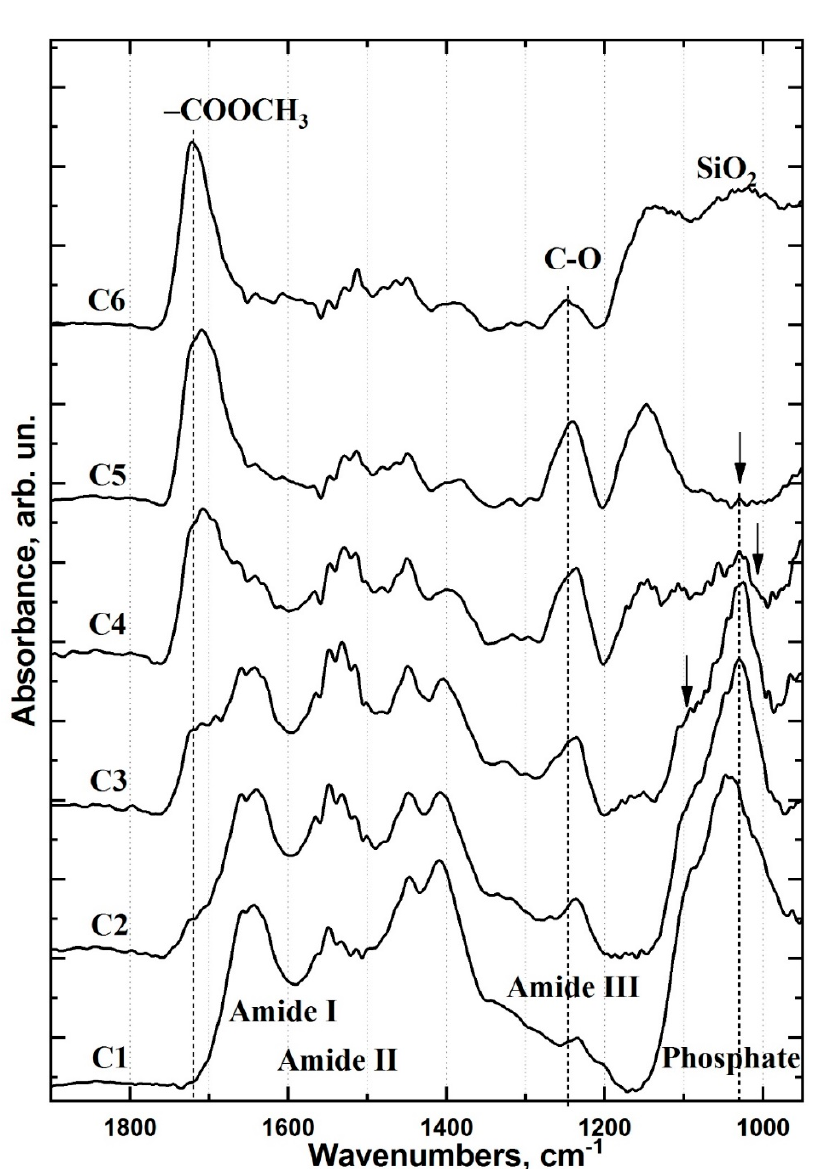
Figure 6. FTIR spectra of type II specimen clusters that are referred to colour-coded clusters C 1 –C 6 for type II specimens in Figure 4b: (C 1 ) FTIR spectrum of type II C 1 cluster (healthy dentine); (C 2 ) FTIR spectrum of type II C 2 cluster (partially disorganised dentine); (C 3 ) FTIR spectrum of type II C 3 cluster (biointerface transition region); (C 4 ) FTIR spectrum of type II C 4 cluster (adhesive and dental material in the interface zone with partially disorganised dentin); (C 5 ) FTIR spectrum of type II C 5 cluster (nano-c-HAp–modified Bis-GMA adhesive); (C 6 ) FTIR spectrum of type II C 6 cluster (Dyract XP light-curing dental compomer).